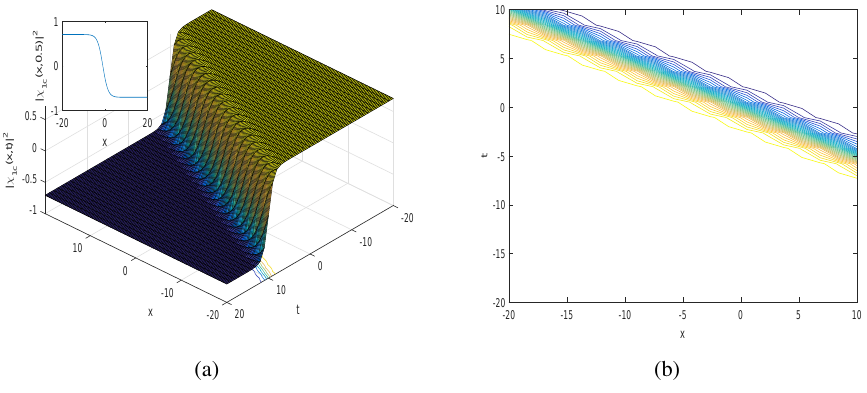
Fig. 2 The (a) 2D, 3D and (b) contour surfaces of Eq. (24).